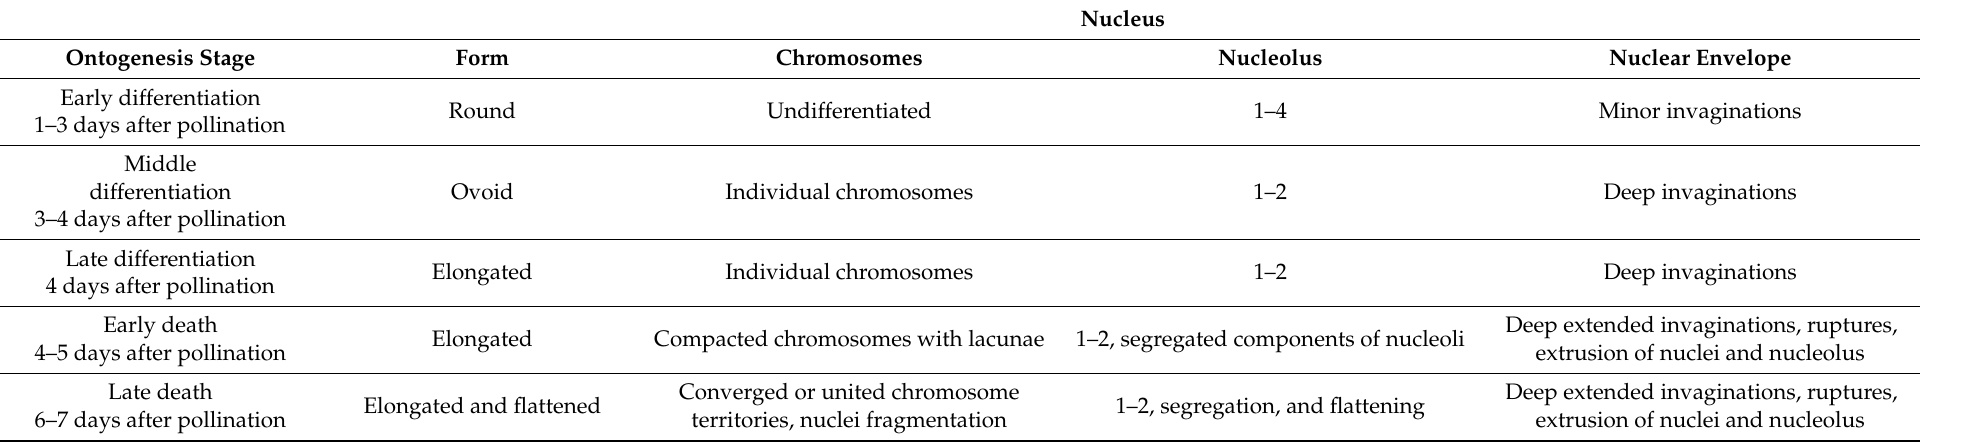
Table 5. The characteristics of the antipodal cell nuclei during differentiation and death.